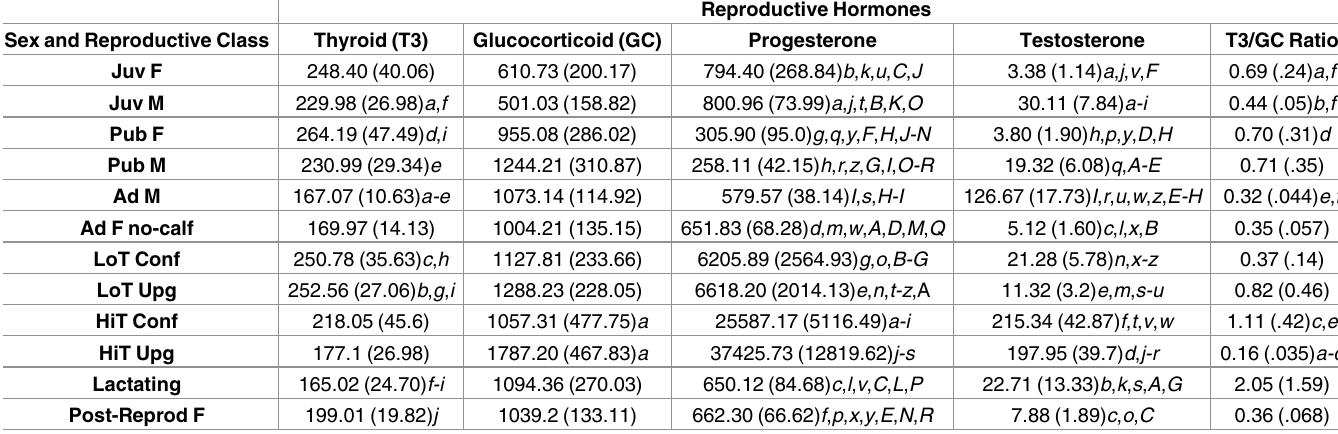
Table 3. Mean hormone concentration (ng/g dry feces) and (standard error) by sex and reproductive class for each hormone measuredduring the study.